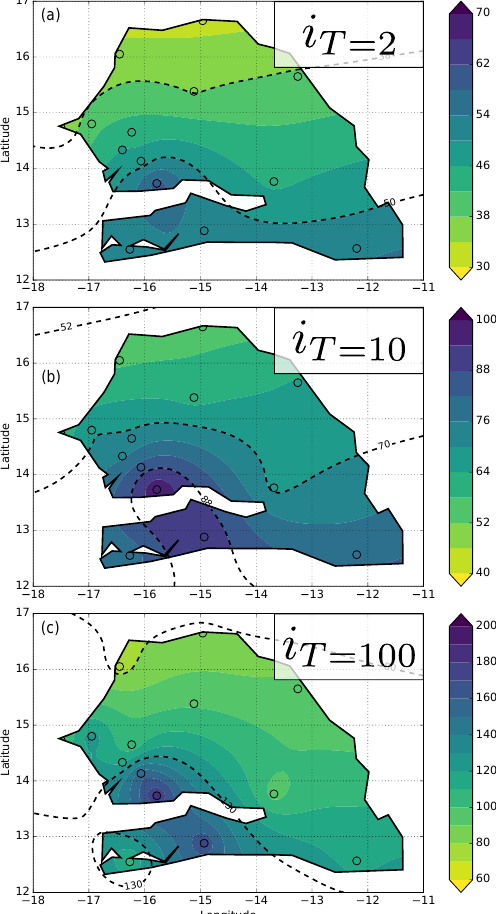
Figure 11. Maps of return levels intensities (from IDF SiSca ) for dif- ferent return periods ( T = 2, 10, and 100 years a–c ) for the refer- ence duration (1h): i T (D = 1 ) [mm h − 1